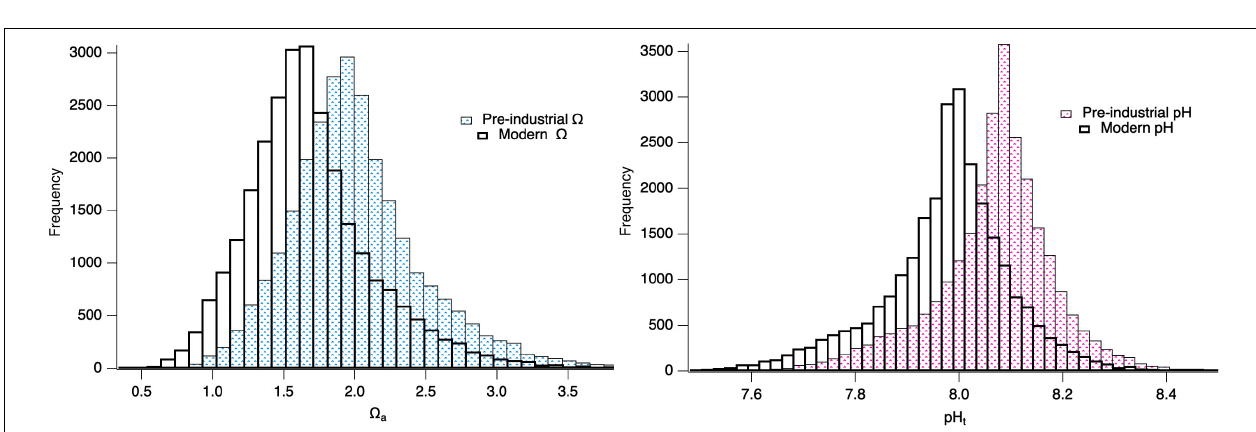
waters expected to be fully undersaturated by the end of century (Feely et al.,